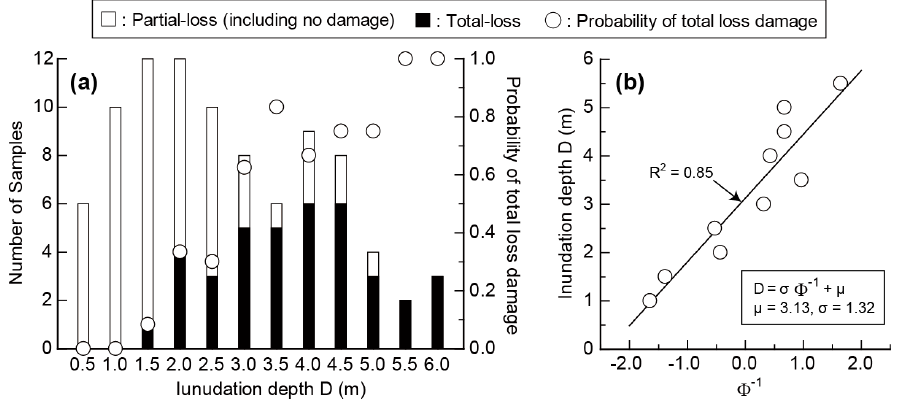
Figure 3. An example of a process for determining the variables as µ and σ on fragility function for fishery warehouse. ( a ) Histogram for the number of the repairable and total loss of fishery warehouse. The class of the inundation depth was made to be the 0.5 m interval, and the repairable and total loss within the range were counted. ( b ) An example of the plot on normal probability paper.